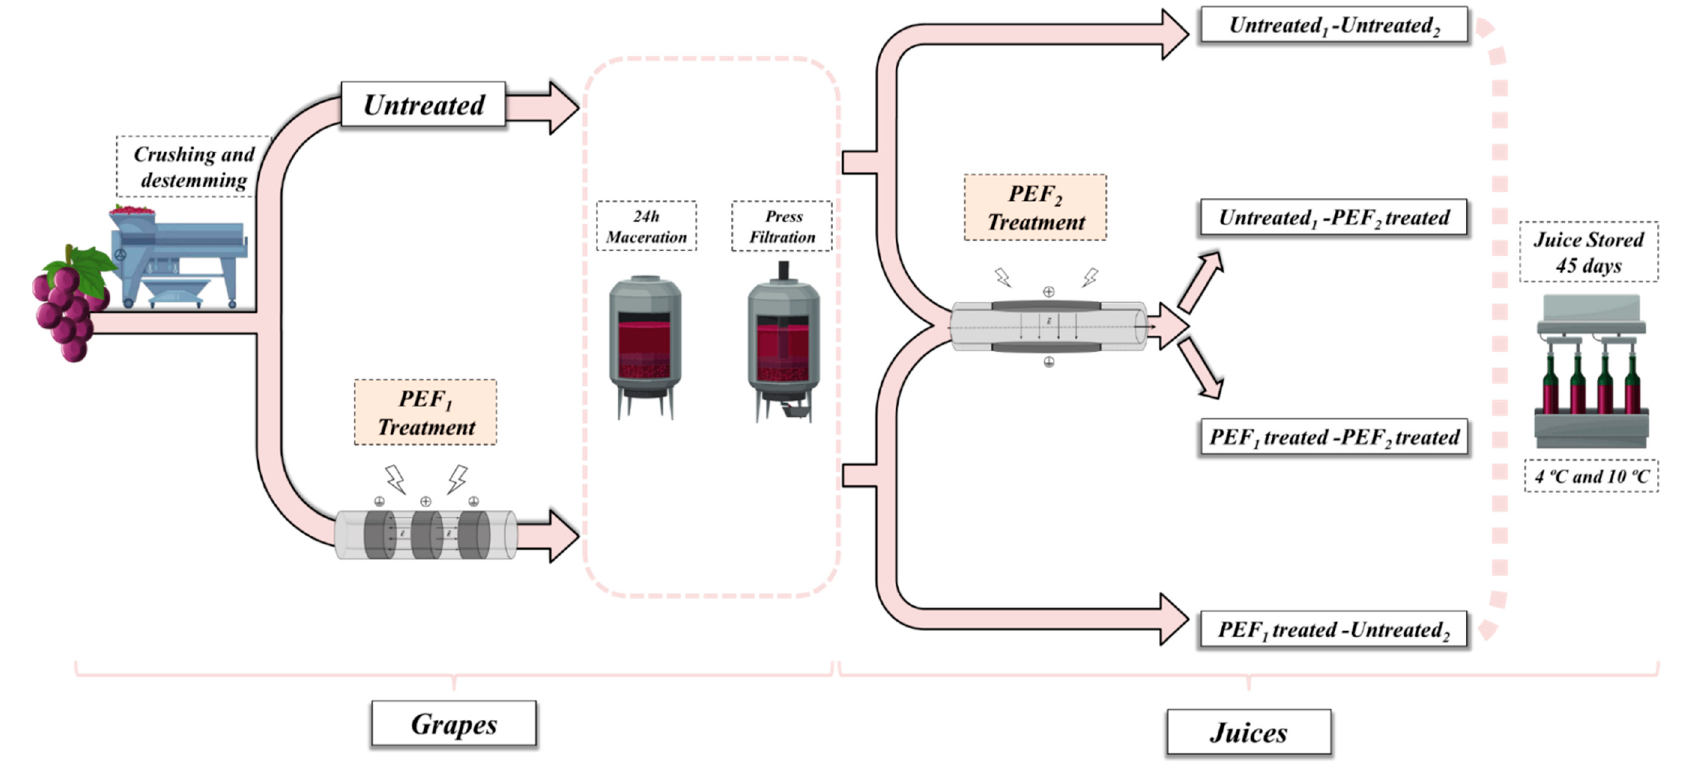
Figure 1. Simplified diagram of the experimental design and procedure accomplished in the present study.